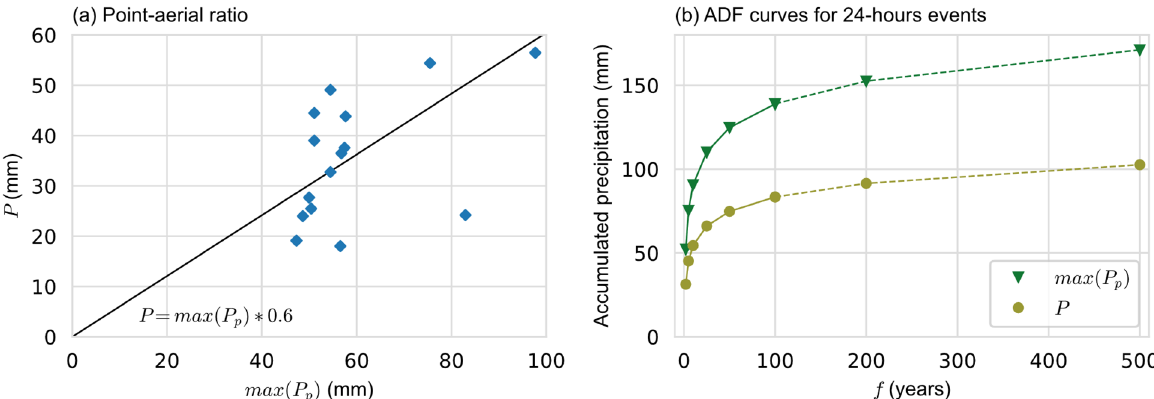
Figure 3. Regression lines related to ( a ) the definition of the point-aerial ratio and ( b ) the 25-h ADF curves, both from reference (solid line) and extrapolated (dashed lines).